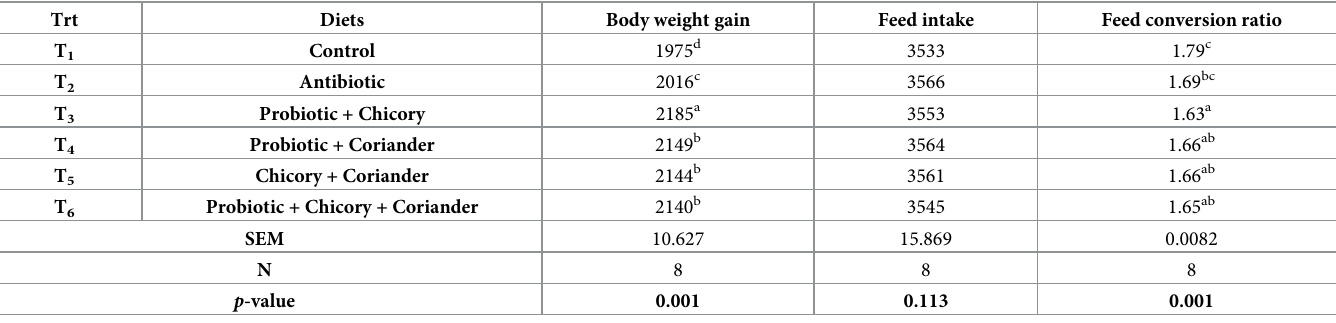
Value bearing different superscripts within a column are significantly (P < 0.05)